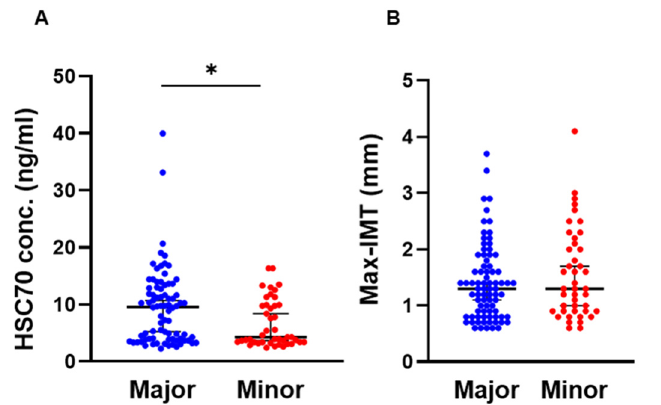
Figure 1. Comparison of serum HSC70 concentration and Max-IMT between HSPA8 genotypes. ( A , B ) HSC70 concentration ( A ) and Max-IMT ( B ) were compared between the patients homozygous for the major allele and those with at least one copy of the minor allele in the patients overall. The middle bar represents the median and the upper/lower bars represent the 95% confidence interval. * p < 0.05. HSC70, heat shock cognate 71 kDa protein; Max-IMT, maximum intima–media thickness. Table 1. Characteristics of patients according to presence of HSPA8 SNP.